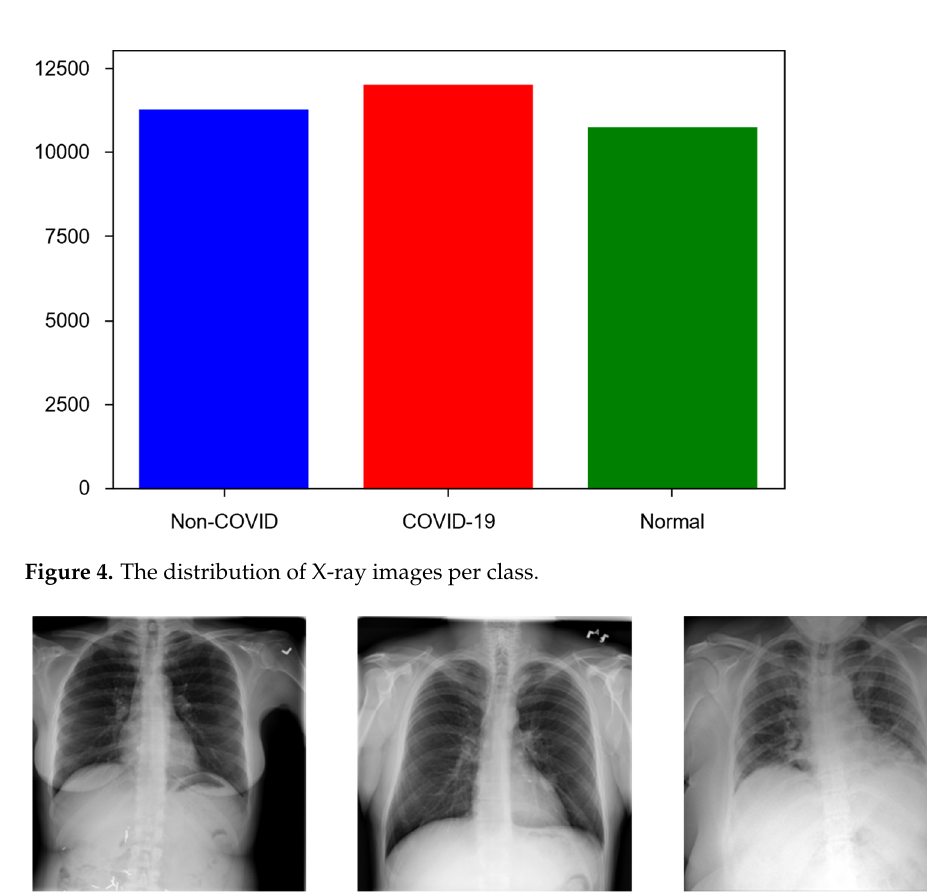
Figure 5. Samples from COVID-QU-Ex dataset From left to right: normal, non-COVID infection, COVID-19. Table 1. The dataset summary across different classes and train-validation-test splits.